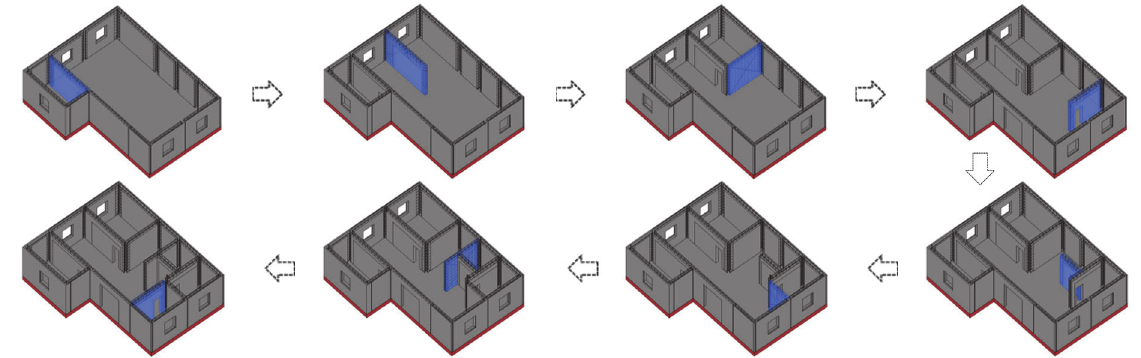
Figure 7. BIM-based visual simulation about testing an assembly